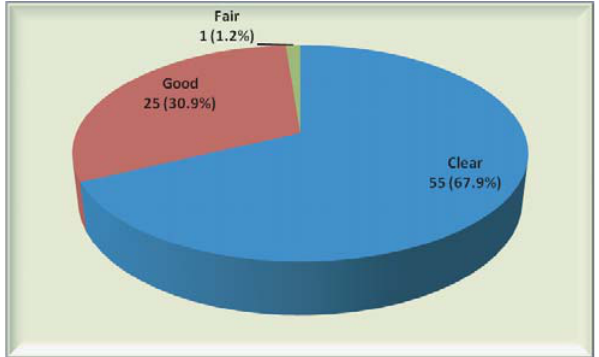
Fig 4. Distribution of patients by global response